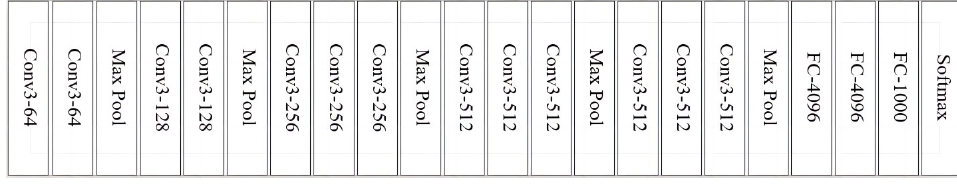
Figure 4. The VGG16 Network